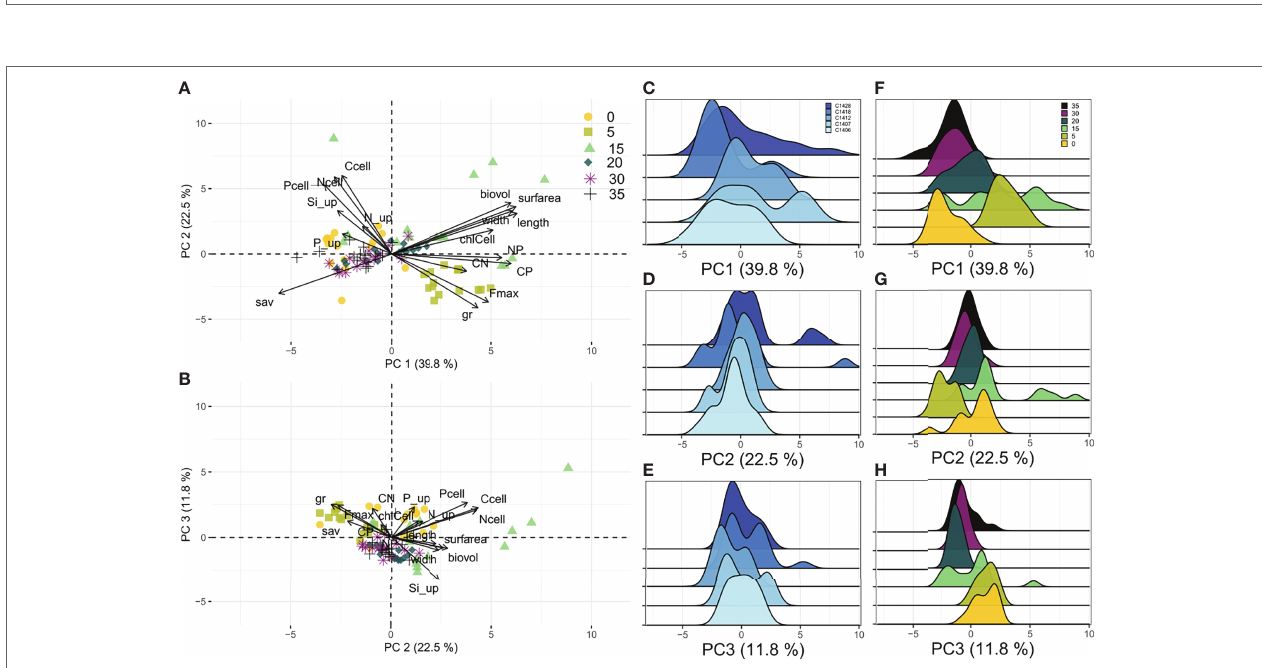
FIGURE 3 | Results of PCA for A. ostenfeldii strains grown under six salinity levels. (A, B) Ordination plots summarizing the variation of traits in all experimental units. (C–E) Individual loading grouped by strain along the first three principal component axes. (F–H) Individual loading grouped by salinity along the first three principal component axes. Traits abbreviations as in Table 1 .